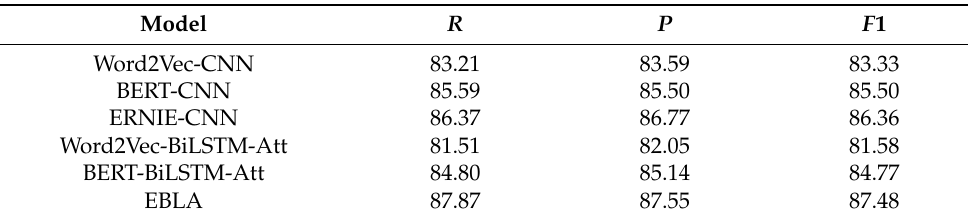
Table 4. Comparative results using different word embedding models